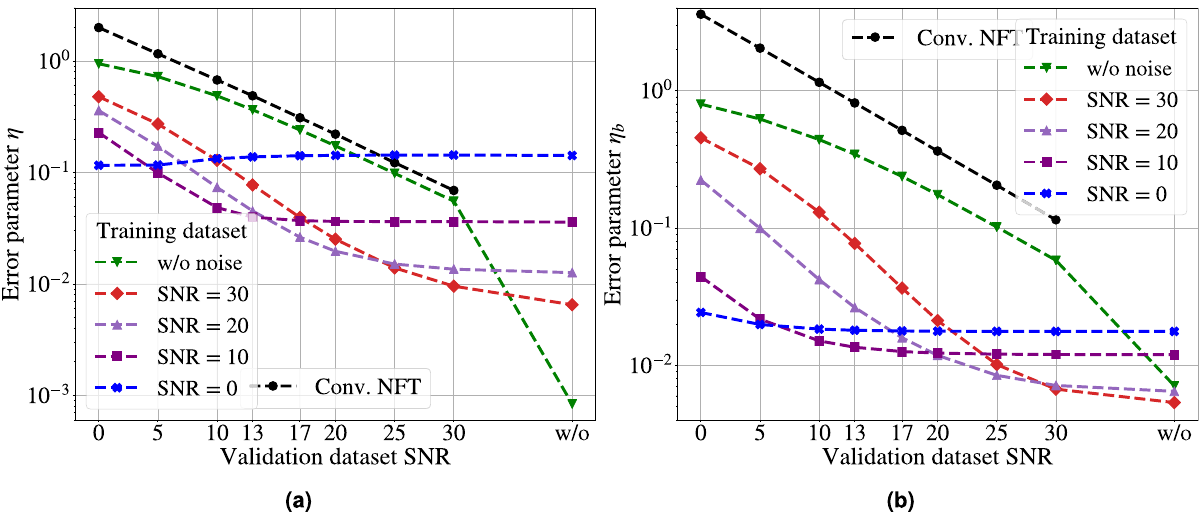
Figure 5. (a) The dependence of the error parameter η (4) for coefficient r (ξ) on the SNR value of the validation dataset for fast conventional NFT and NFT-Net trained at different noise levels. (b) The same for the error parameter η b (5) for coefficient b (ξ) . The black line represents the error value for fast NFT applied to noisy signals, and the points below this line refer to the cases when the NFT-Net outperforms conventional computations. Other lines show the value of the error in calculating the continuous spectrum using NFT-Net, trained with different noise levels: green—without additional noise, red—with additional noise with SNR = 30 dB, violet—at SNR = 20 dB purple—at SNR = 10 dB, blue—at SNR = 0